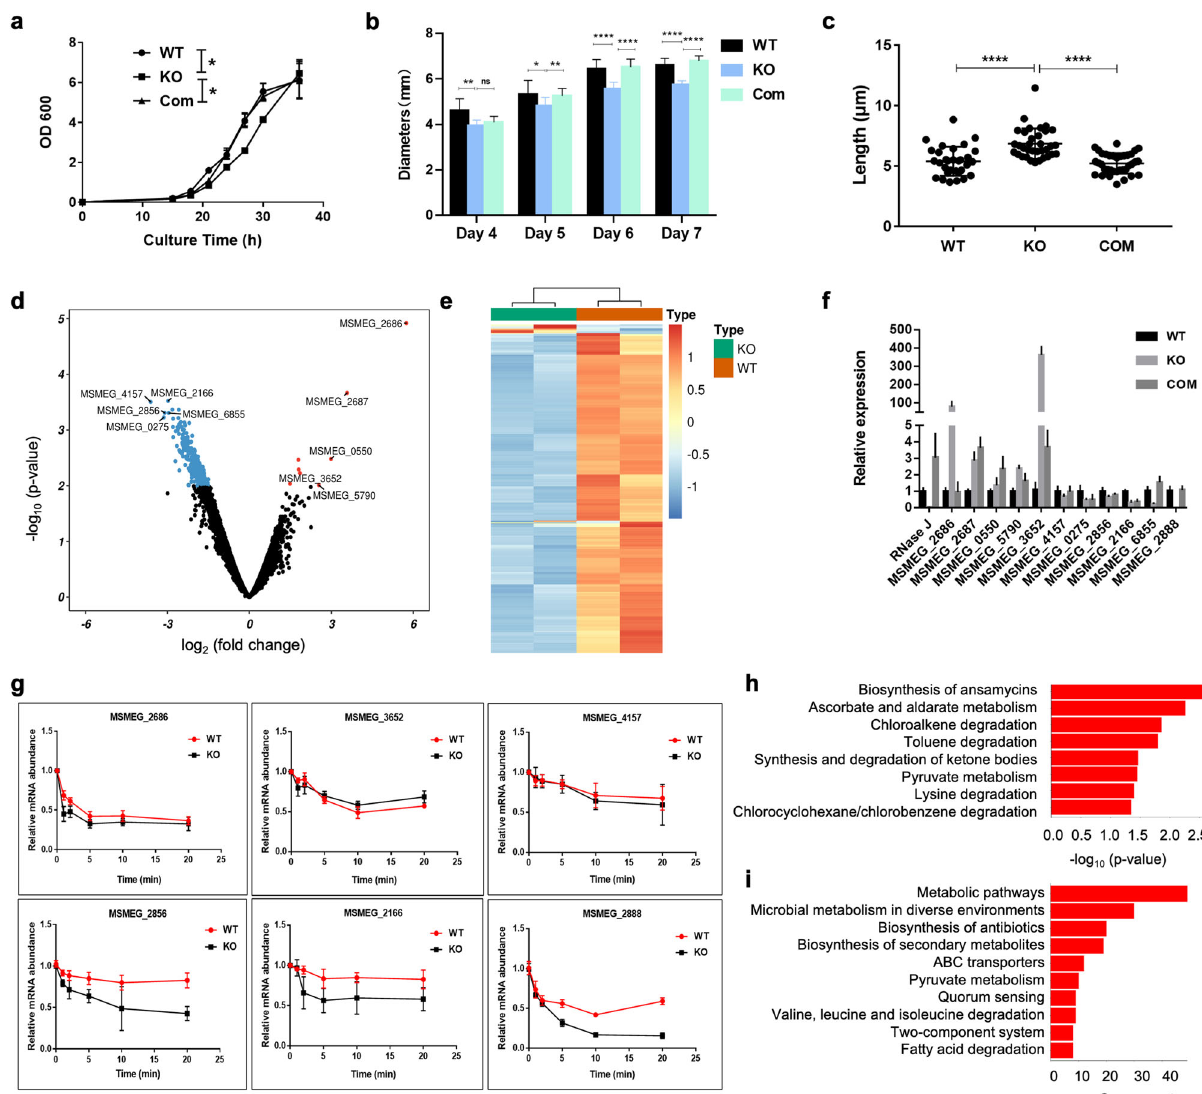
Fig.7|RNaseJaltersthegrowthandmorphologyof Mycobacteriumsmegmatis byaffectingcellwallsynthesisandlipidmetabolism.a Thegrowthcurveofwild- type (WT), RNase J KO, and RNase J complemented (COM) Msm strains. b The colony sizedifferenceamong WT, KO, and COMMsm strains. c Cell lengths of WT, KO, and COM strains with transmission electron microscopy (TEM) observation. d Volcano plot of differentially expressed genes between WT RNase J and its KO strain by RNA-seq analysis. The signi fi cant differentially expressed genes were labeled by the standard of pval<0.05&|log2FC|>1, up as red, down as blue. e Heat